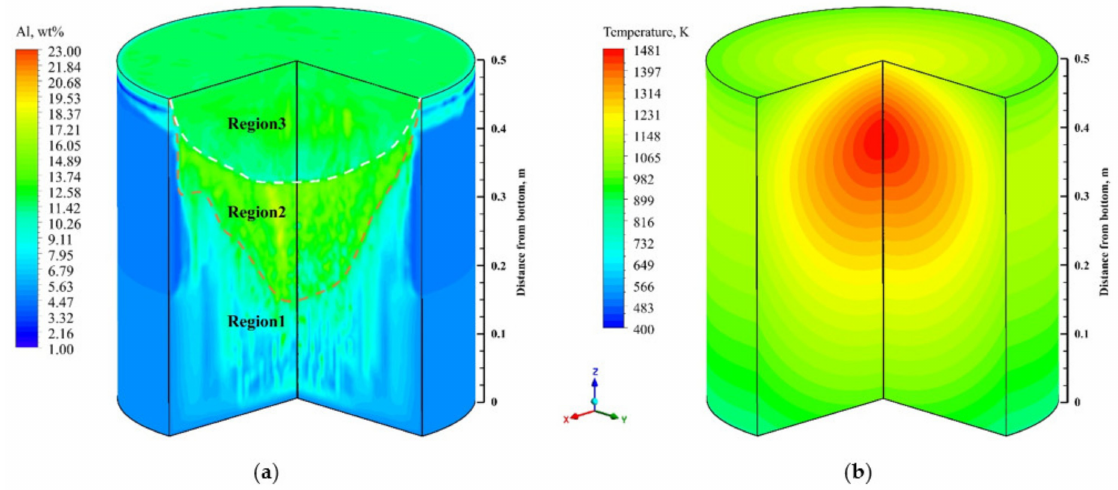
Figure 11. Results after solidification: ( a ) solute distribution and segregation behavior; ( b ) temperature